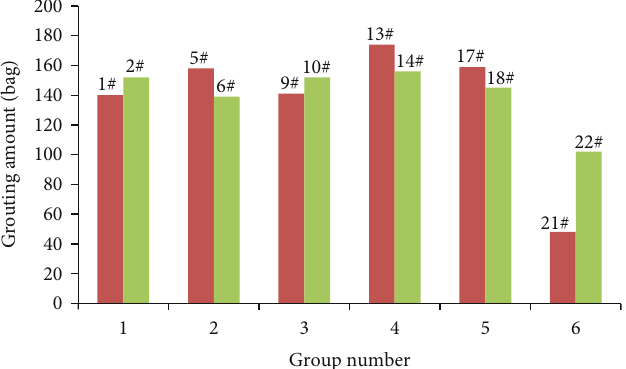
Figure 7: Borehole grouting volume for the boreholes drilled into the longwall working face.